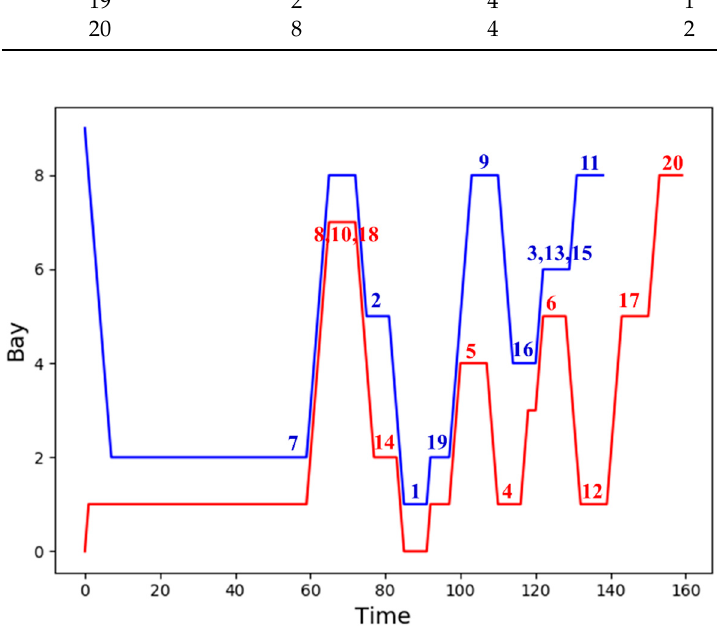
Figure 4. Twin yard cranes operation after Tasks’ release time renewal